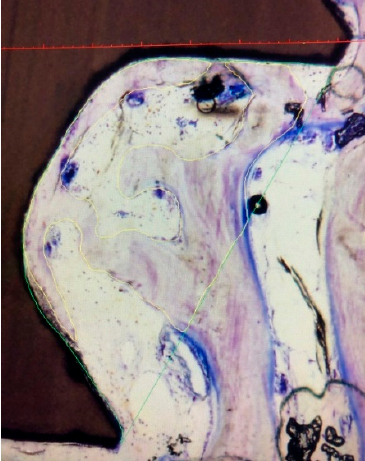
Figure 4. Determination of the BAFO: percentage of bone (area surrounded by yellow marking) in the healing chamber (area surrounded by green marking).